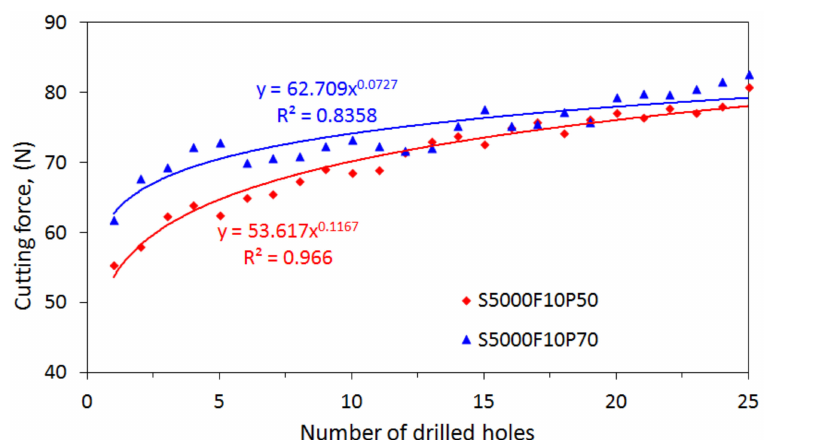
Figure 7. Comparisons of the cutting forces under process parameters A3B1C2 and